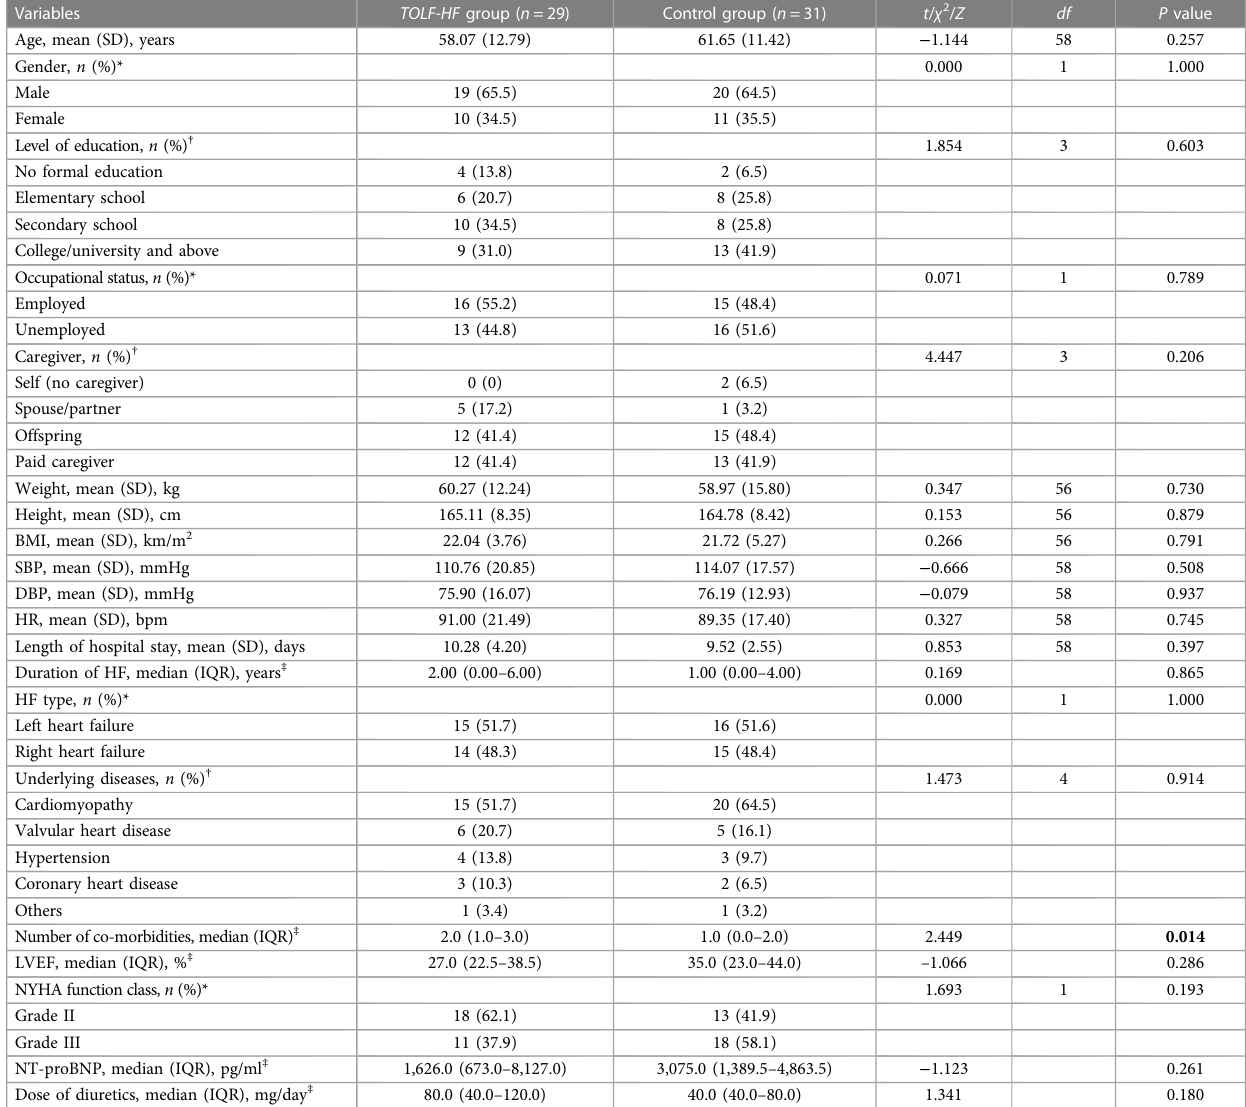
TABLE 2 Baseline characteristics of study participants.